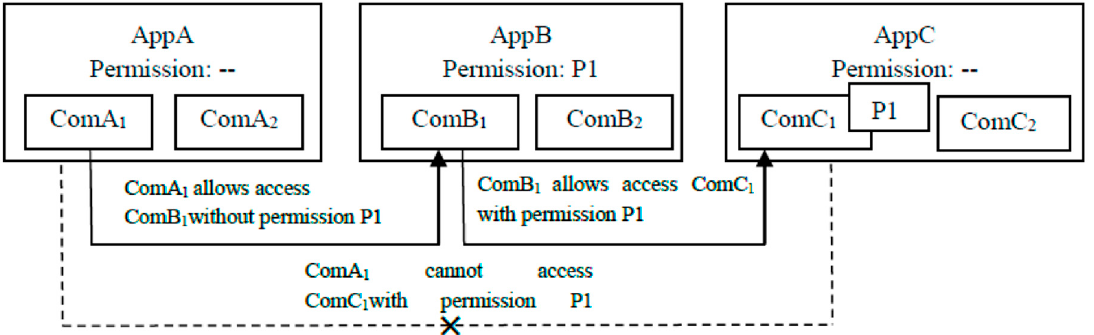
Figure 1. Diagram of a privilege escalation